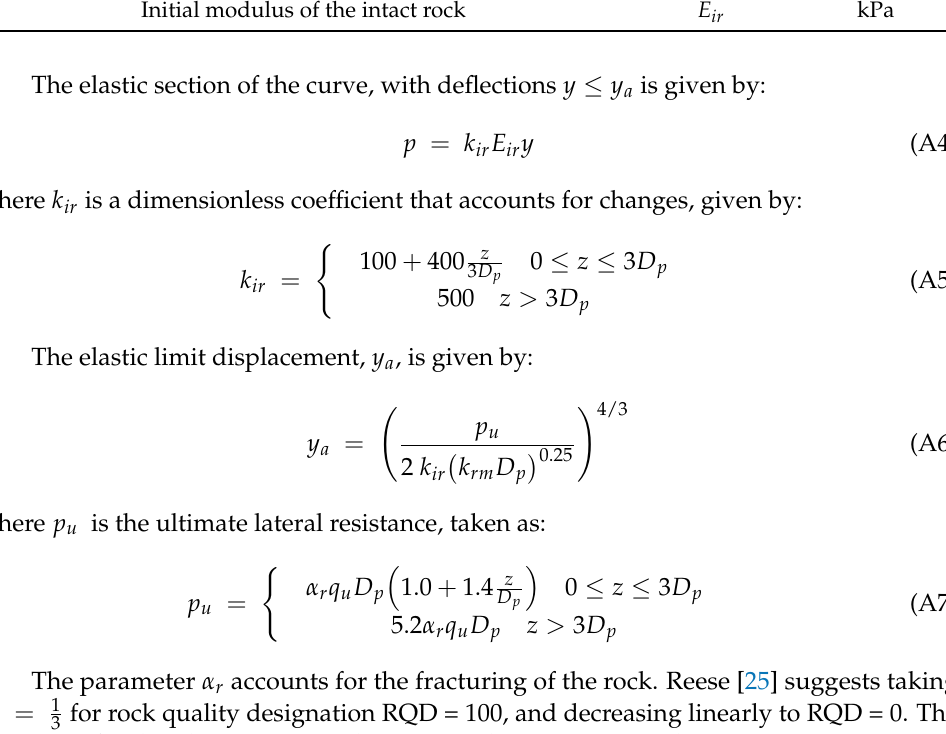
Table A1. Parameters that define p–y curves on weak rock. Parameter Symbol Unit Uniaxial unconfined strength q u kPa Strength reduction factor α r - Dimensionless coefficient in the range of 5 × 10 − 4 and 5 × 10 − 5 k rm - Initial modulus of the intact rock E ir